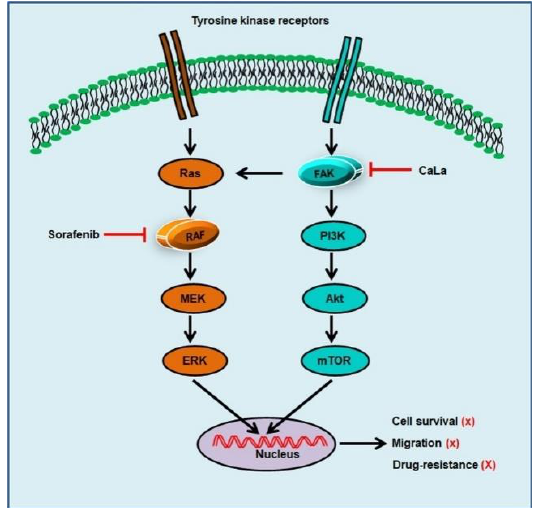
Figure 5. Schematic illustration of the signaling pathways that can be inhibited by sorafenib and calcium influx. Sorafenib inhibits the mitogen-activated protein kinase pathway following recombinant activated factor (RAF) inhibition, and calcium influx inhibits steroid receptor coactivator (Src)-mediated focal adhesion kinase (FAK), resulting in the inhibition of phosphoinositide 3-kinases (PI3K) / Akt / mammalian target of rapamycin (mTOR)